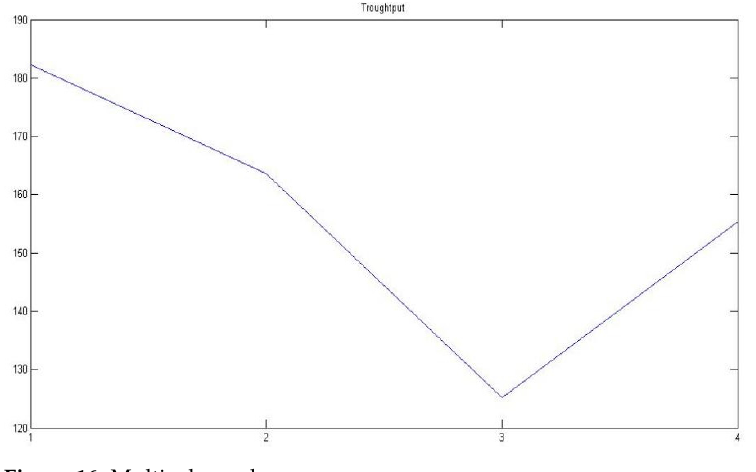
Figure 15. Throughput parameters MCCH. Table 13 is the result of the Throughput of the MCCH algorithm. Table 13. Throughput parameters MCCH .